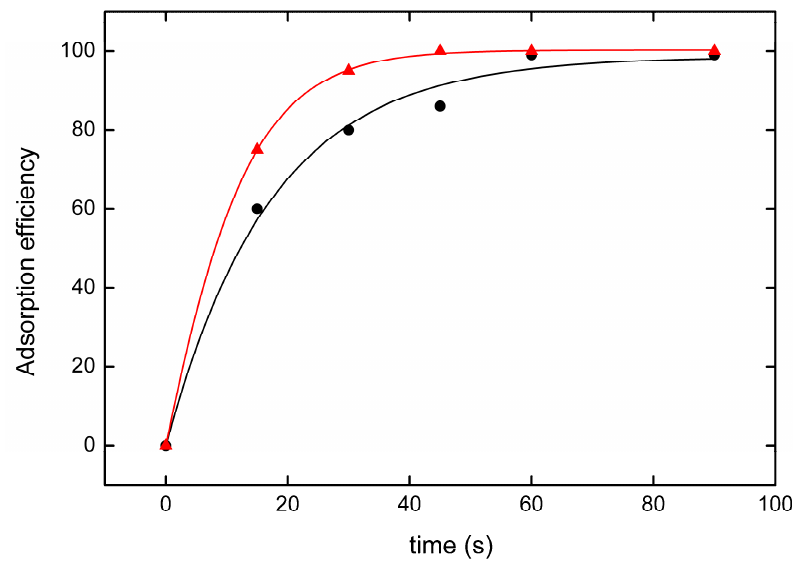
Figure 7. Dependence of the adsorption efficiency on time of contact between Fe 3 O 4 @AgNPs and nitrate for 50 mg L − 1 of nitrate concentration and 500 µL of adsorbent (black dots), and 10 mg L − 1 and 500 µL (red triangles). Solid lines are the fits to the kinetic model introduced by Equation (3).